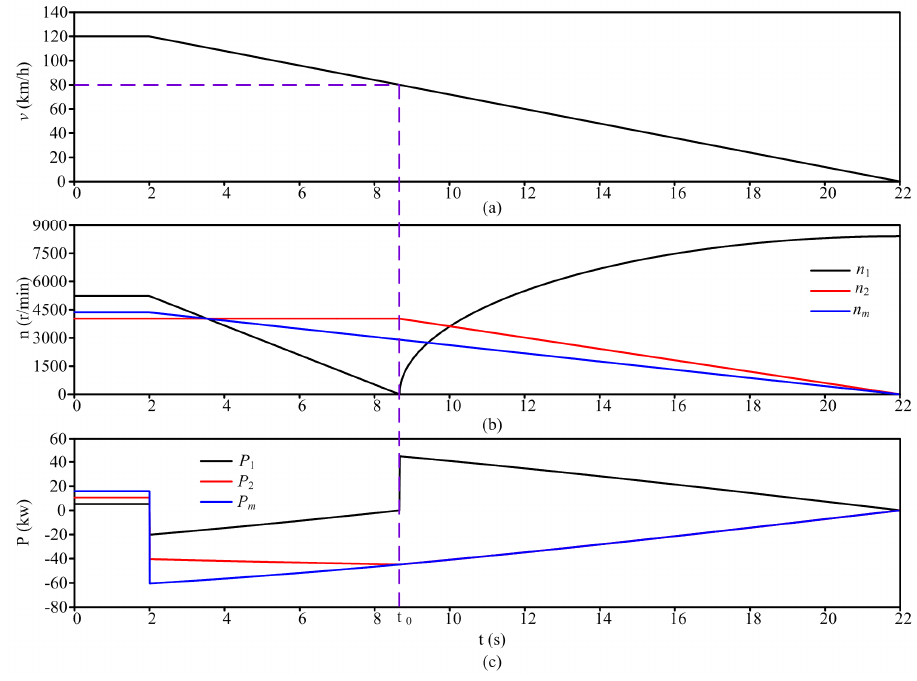
Figure 9. Mode 4: ( a ) Required vehicle velocity; ( b ) Rotational speeds; ( c ) Powers.